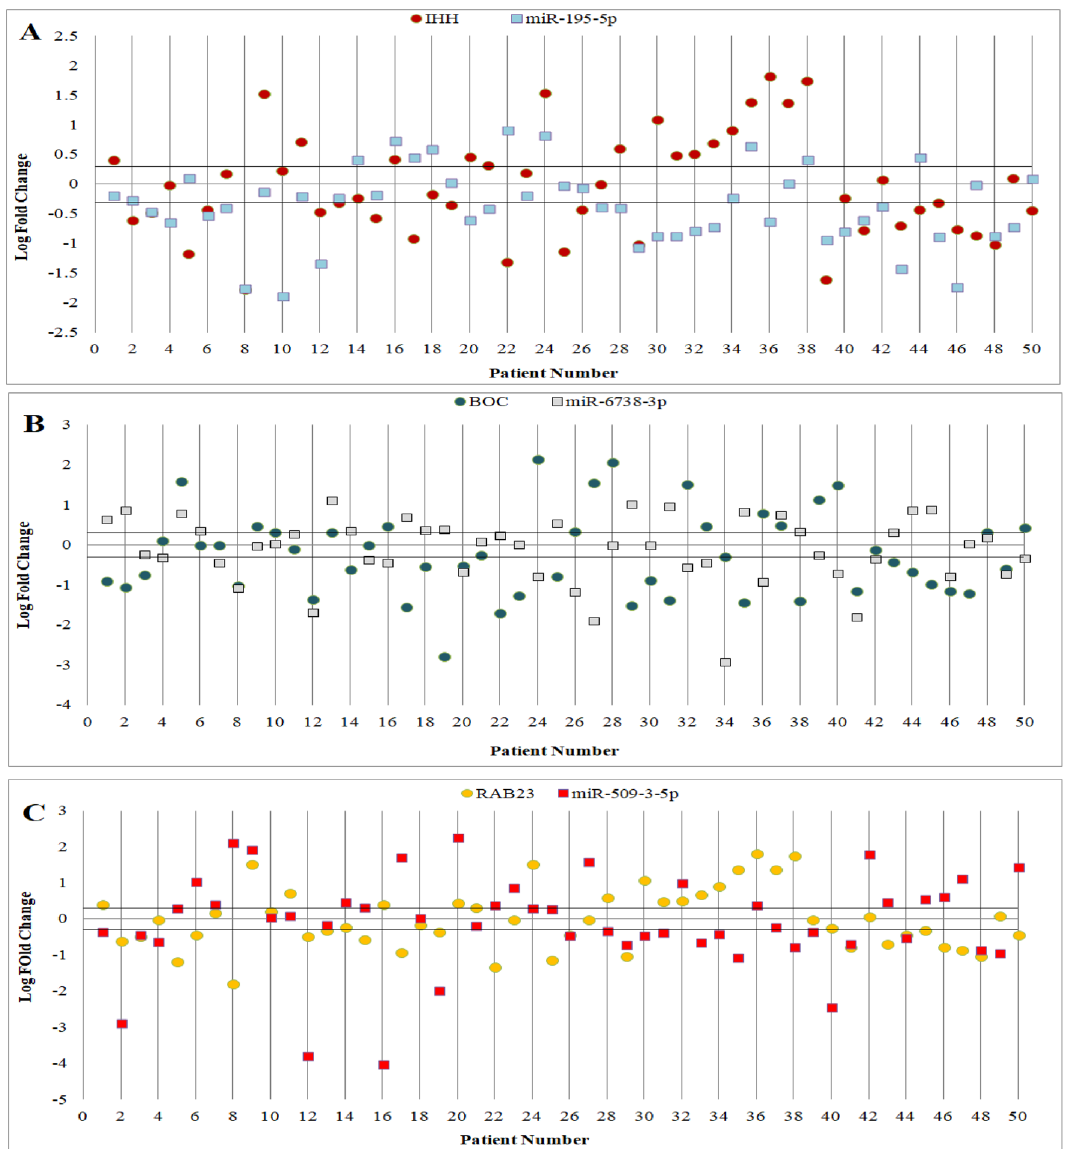
Figure 3. Scatter plot of gene expression in tumoral and adjacent non-tumoral tissues of 50 gastric adenocarcinoma patients. Each plot represents a person’s gene expression change in tumor tissue compared with adjacent normal tissue. Horizontal black lines represent cut ‐ off values (log2 fold changes in expression). Cases above the upper line demonstrated overexpression in tumoral in comparison with non-tumoral tissues, and those below the lower line demonstrated lower expression levels (differences in expression ≥ 2; P <